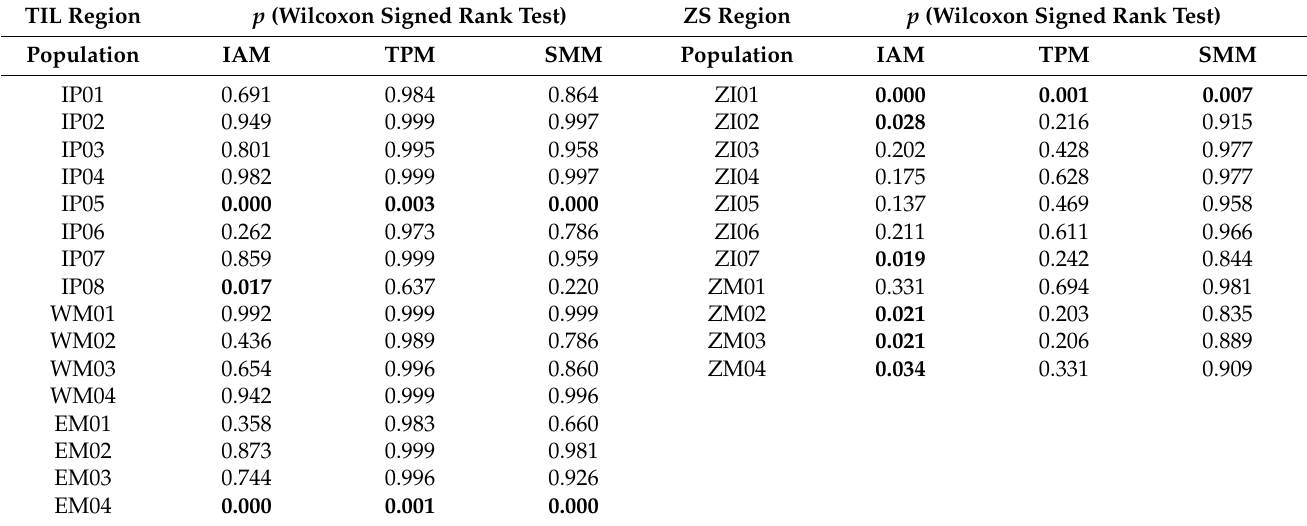
Table 5. Bottleneck analyses for a total of 27 populations of Hedyotis chrysotricha , including 16 from the Thousand-Island Lake (TIL) region and 11 from the Zhoushan Archipelago (ZA) region. The p -values are shown for the Wilcoxon signed rank tests, as evaluated under the infinite alleles model (IAM), the two-phase mutation model (TPM), and the stepwise mutation model (SMM),